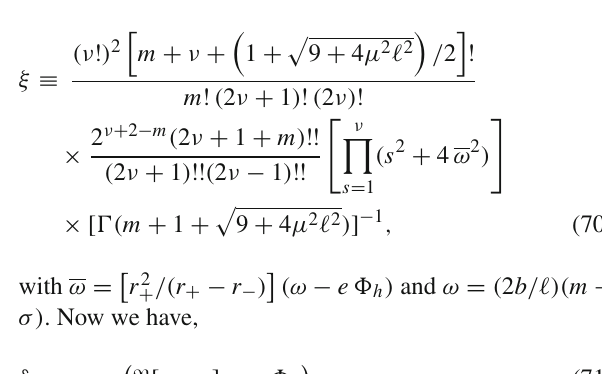
Fig. 1 Graphof e (cid:3) h and (cid:16) (ω QM ) asafunctionof b 2 for m = 0, ν = 1, (cid:9) = − 3 × 10 − 6 , Q = 0 . 8, μ = 0 . 1, e = 0 . 205 − 0 . 220 with different chargevaluesofscalarfield.As b 2 becomessmaller,whichcorresponds to larger values of η , we see that the condition δ AdS > 0 starts not to hold. Instability condition only holds above the intersection points for these choosen parameter values. Note that, the black hole charge value Q = 0 . 8 is in accordance with